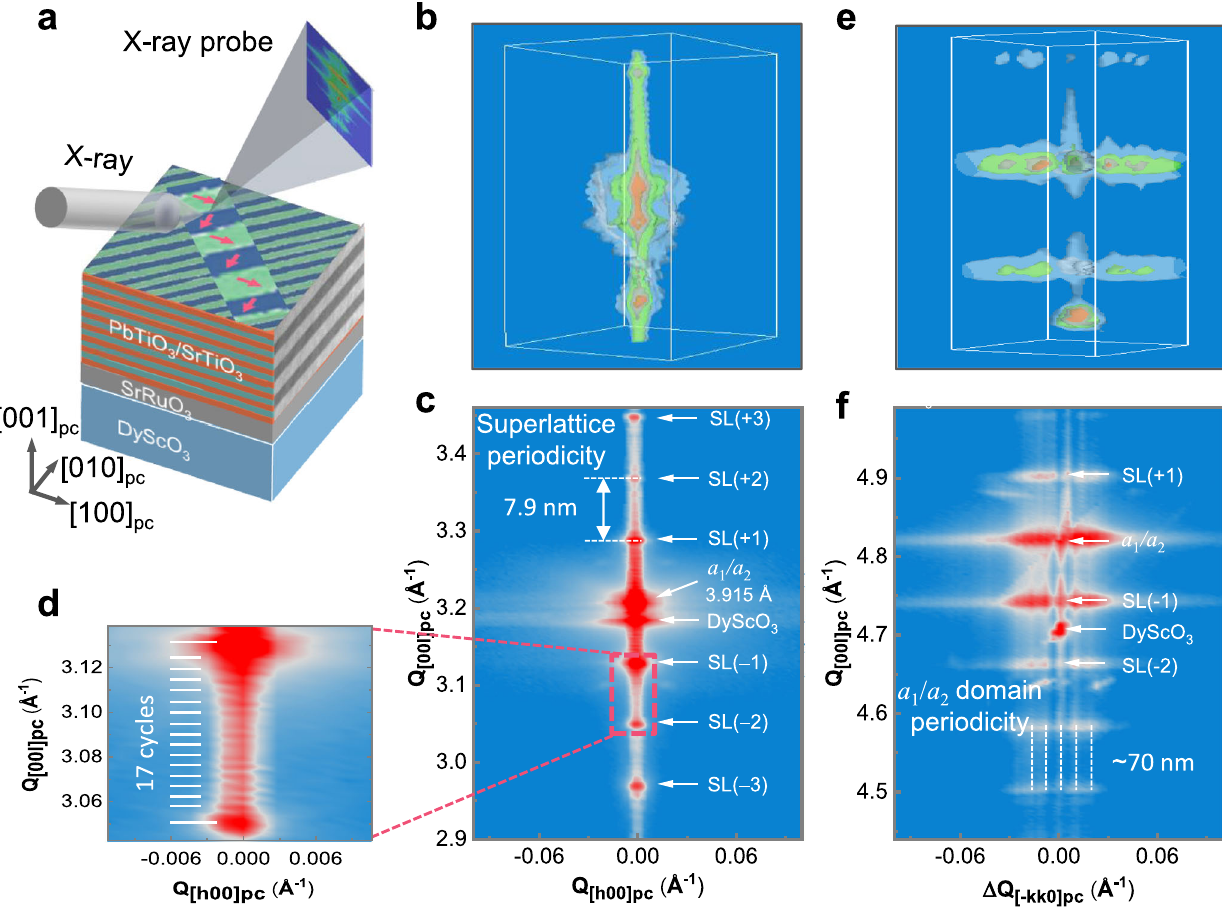
Fig. 3 3D-RSM characterization of the (PTO) 10 /(STO) 10 superlattice. a Schematic of X-ray diffraction of (PTO) 10 /(STO) 10 superlattice. b 3D-RSM around 002 pc Bragg spot of the DyScO 3 substrate and ( c , d ) the corresponding planar slice along Q [ h 00] -Q [00l] , showing the re fl ections of PTO a 1 / a 2 domains and stacking superlattice. e 3D-RSM around 103 pc Bragg spot of the DyScO 3 substrate and ( f ) the corresponding planar slice along Q [ − kk 0] -Q [00l] showing the in-plane diffractive satellites along < − kk 0>